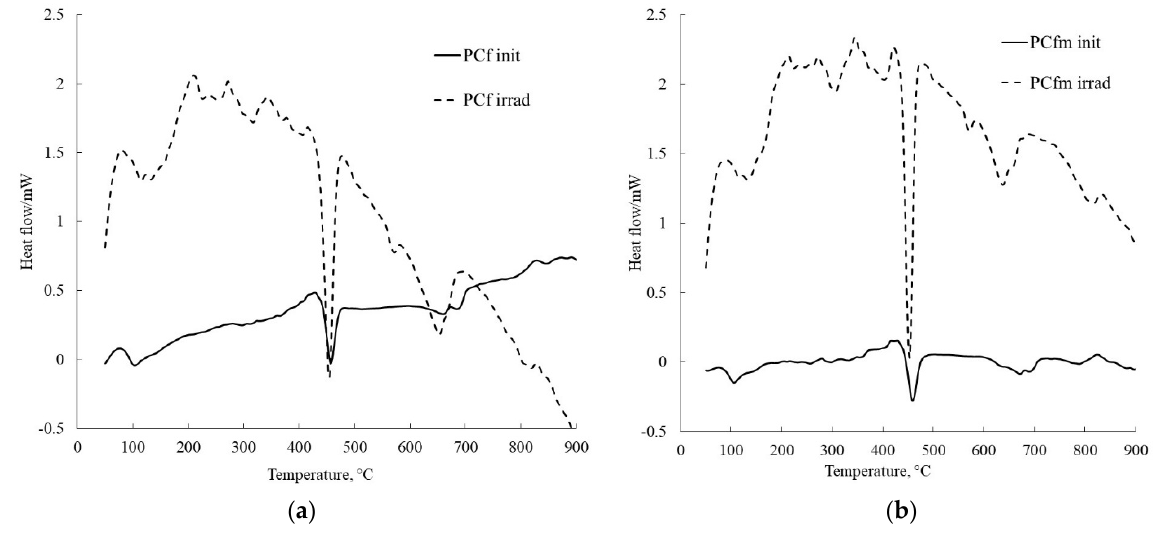
Figure 15. Thermograms of initial and irradiated PCf ( a ) and PCfm ( b ) concretes.